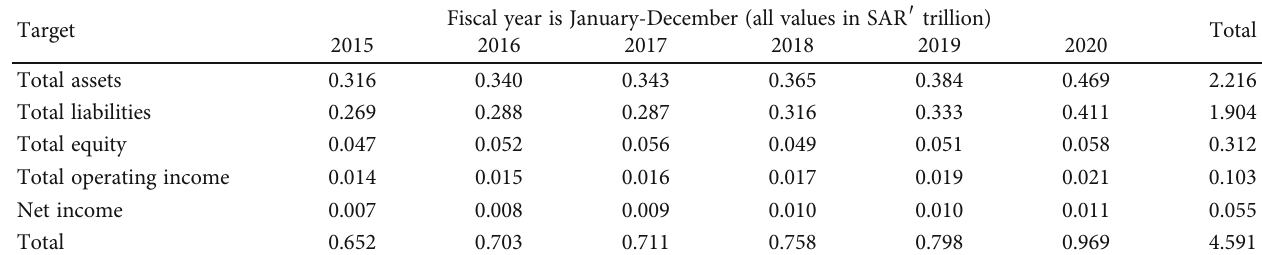
Table 3: Financial data from the Al Rajhi Bank in coded form.